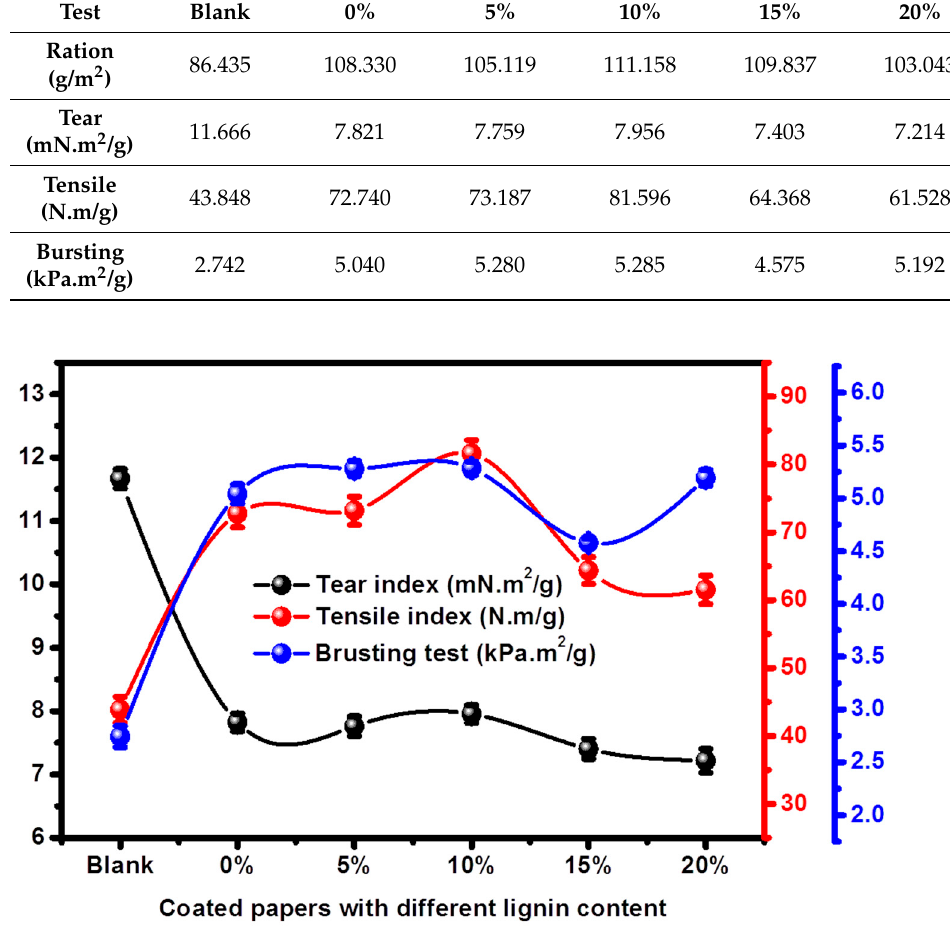
Figure 4. The physical properties of the blank paper and the papers coated with PVAc and its copolymers containing different fractions of lignin. Table 1. The values of ration, tearing, tensile, and bursting tests of the blank paper and paper coated with PVAc and its copolymers containing different fractions of lignin.